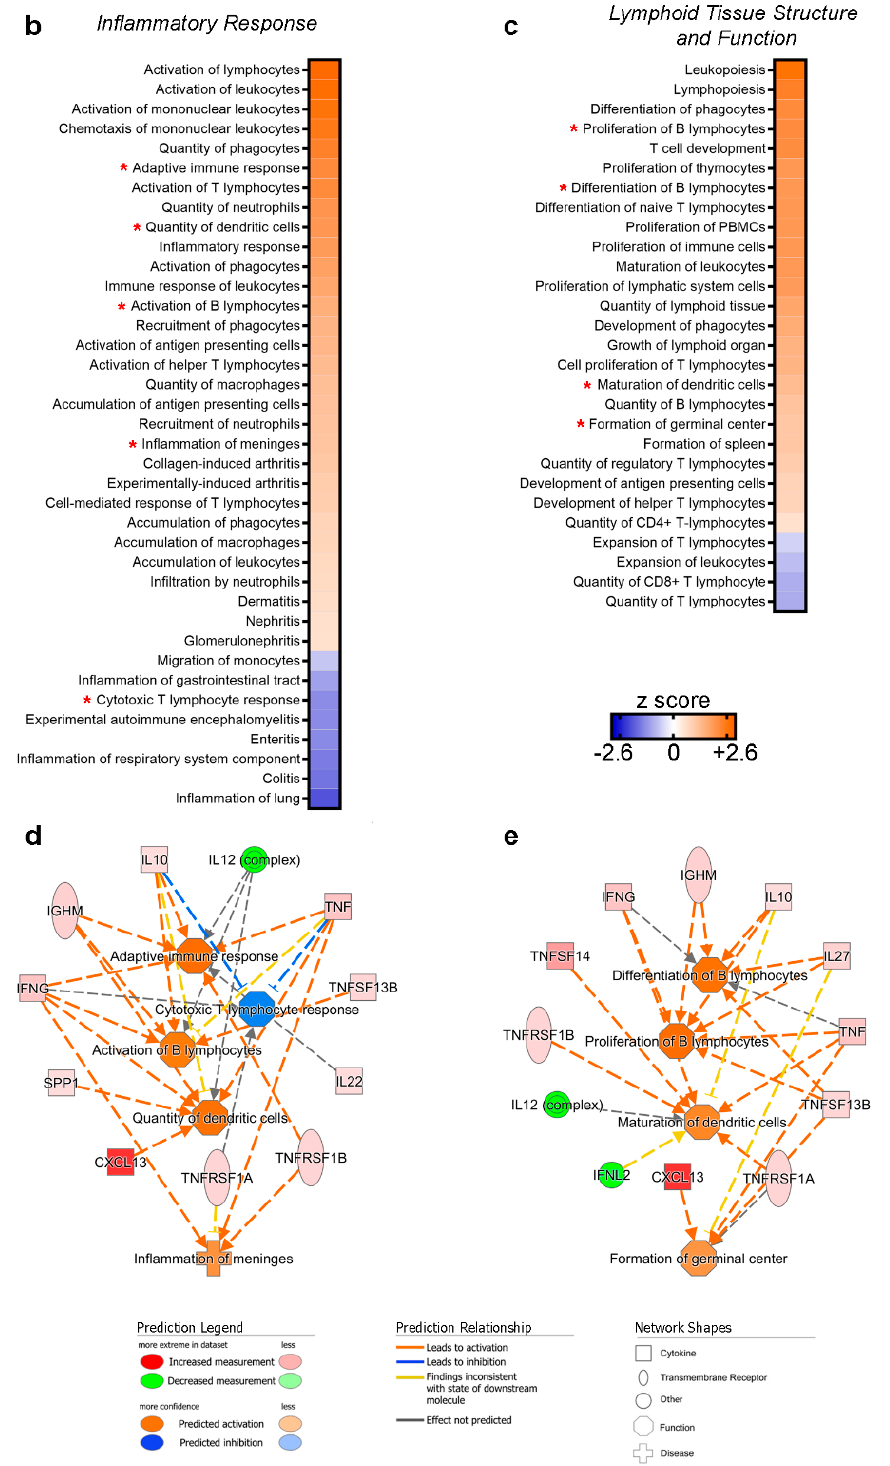
Figure 6. ( a ) Inquiry of disease and functions annotations revealed many categories with highly significant B-H corrected p -values related to inflammation (inflammatory response and disease, immunological disease) and immune cells processes (lymphoid tissue structures and development, immune cell trafficking). See Supplementary Table S4 for the complete analysis of disease and func- tion categories. ( b , c ) Heatmaps of functional annotations encompassed in inflammatory response and lymphoid tissue structure and development from ( a ). All these functions showed a |z-score| > 0.5; annotations marked by red asterisk were further utilised to generate networks in panel ( d , e ). For the complete list of the annotations enclosed in the two categories see Supplementary Tables S5 and S6. ( d , e ) Networks from selected annotations of inflammatory response ( d ) and lymphoid tissue structures and development categories ( e ) pinpointed an involvement of adaptive immunity and B cell response; conversely, annotations related to T cell response were associated with negative z- score, predicting an inhibition state. Notably, inflammation of meninges was also found to be acti- vated: this prediction was supported by the increased expression of IFN- γ , TNFRS1B/TNF-R2 and TNF (orange arrows), whereas TNFRS1A/TNF-R1 showed an inconsistent relationship (yellow ar-